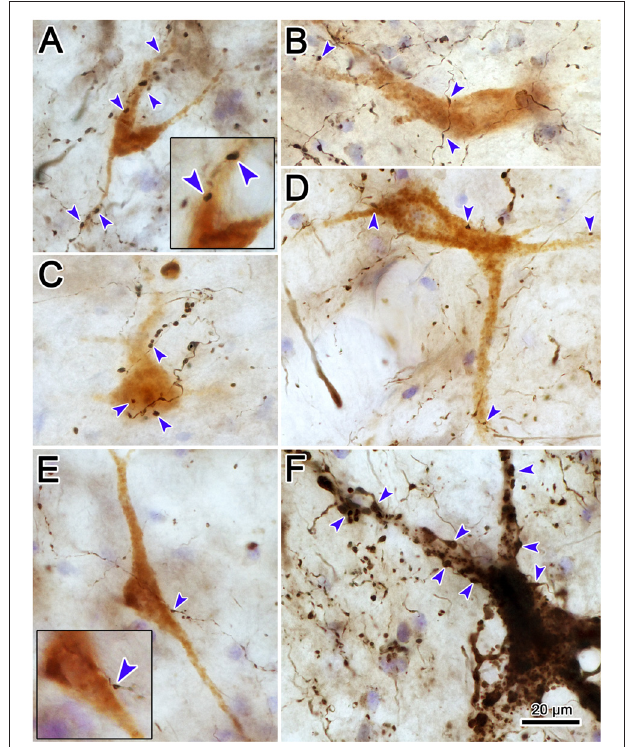
cMRF cells. Photomicrographs show examples of close associations (arrowheads) between brown, retrogradely labeled reticuloreticular neurons and black, anterogradely labeled tectoreticular terminals (A–E) . Individual axons display one or two boutons associated with the cell in most (B,D,E) , but not all (A,C) , cases. In contrast, black, BDA labeled tectoreticular terminals line up along the dendrites of the black, BDA labeled reticulotectal neurons in the same case (F)